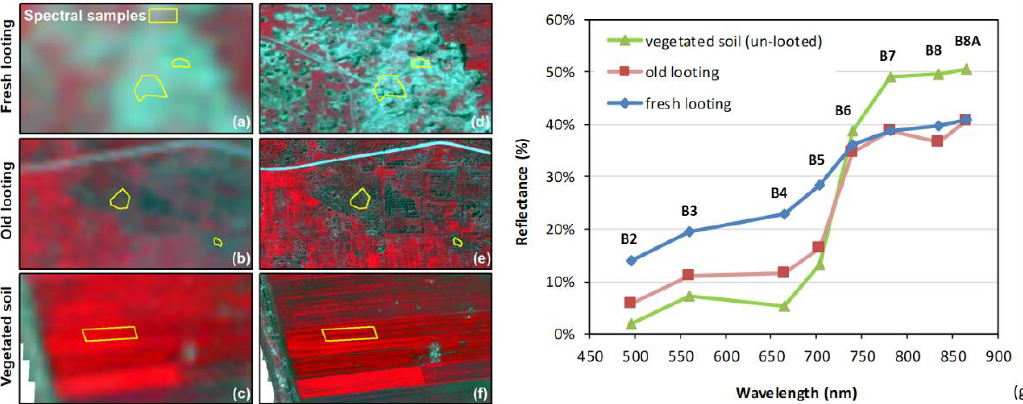
Figure 12. Spectral analysis of samples of: ( a ) fresh looting, ( b ) old looting, and ( c ) vegetated soil (un-looted) identified on 10-m false-colored infrared Sentinel-2 image (21 / 04 / 2017; R: Band 8—NIR; G: Band 4—red; B: Band 3—green; see Figure 11a) and ( d – f ) nearly coeval false-colored infrared WorldView-2 image (03 / 04 / 2017; R: Band 4—NIR1; G: Band 3—red; B: Band 2—green; see Figure 10a). ( g ) Extracted spectral profiles of surface reflectance in Sentinel-2 VIS and NIR bands (Band 2 to Band 8A). Contains modified Copernicus Sentinel-2 data 2017. WorldView-2 product © 2018 DigitalGlobe, Inc. Distributed by e-GEOS